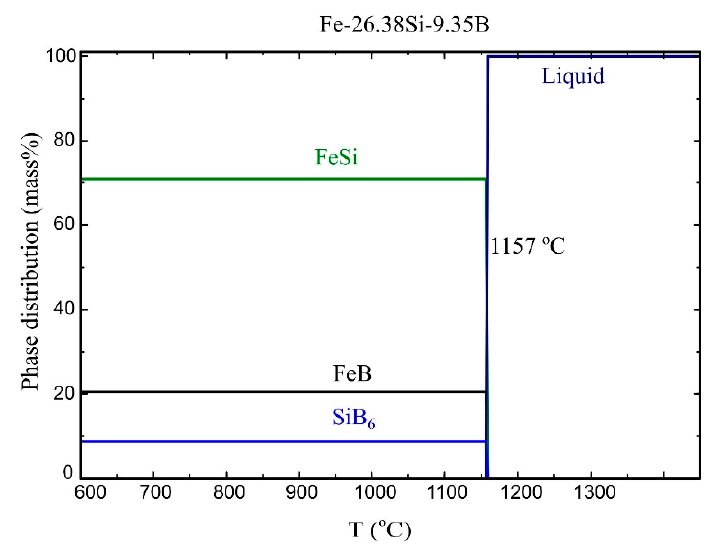
Figure 2. Cooling path of the Fe-26.38Si-9.35B alloy calculated by FactSage.